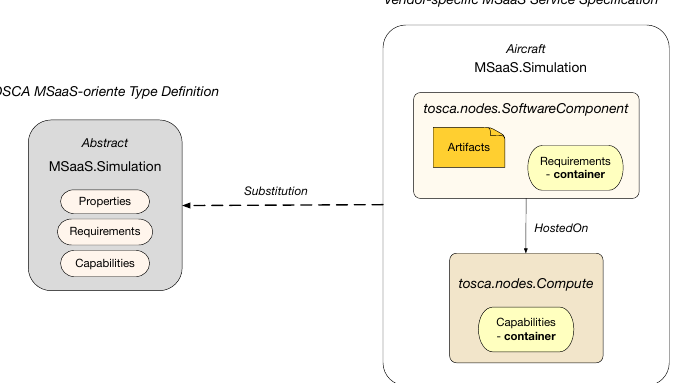
Figure 7. Service substitution principle.